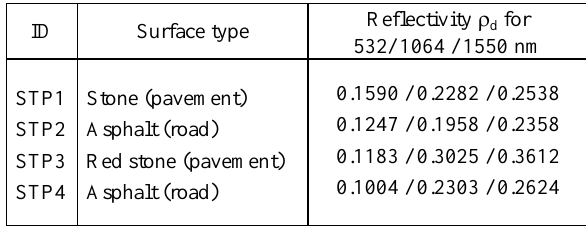
Table 1. In-situ measured reflectivity for 532nm, 1065nm and 1550nm at an incidence angle  of zero (observation of the surface in normal direction) for the selected reference